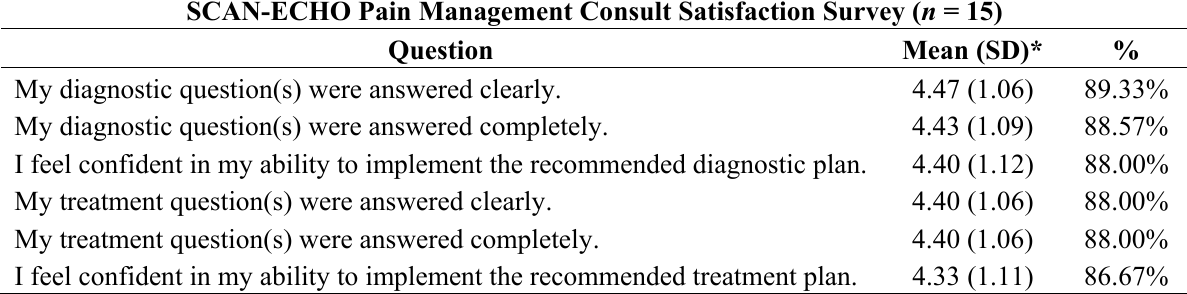
Table 3. Responses to SCAN-ECHO pain management post-meeting Consult Satisfaction Survey (sent only to providers who had a case